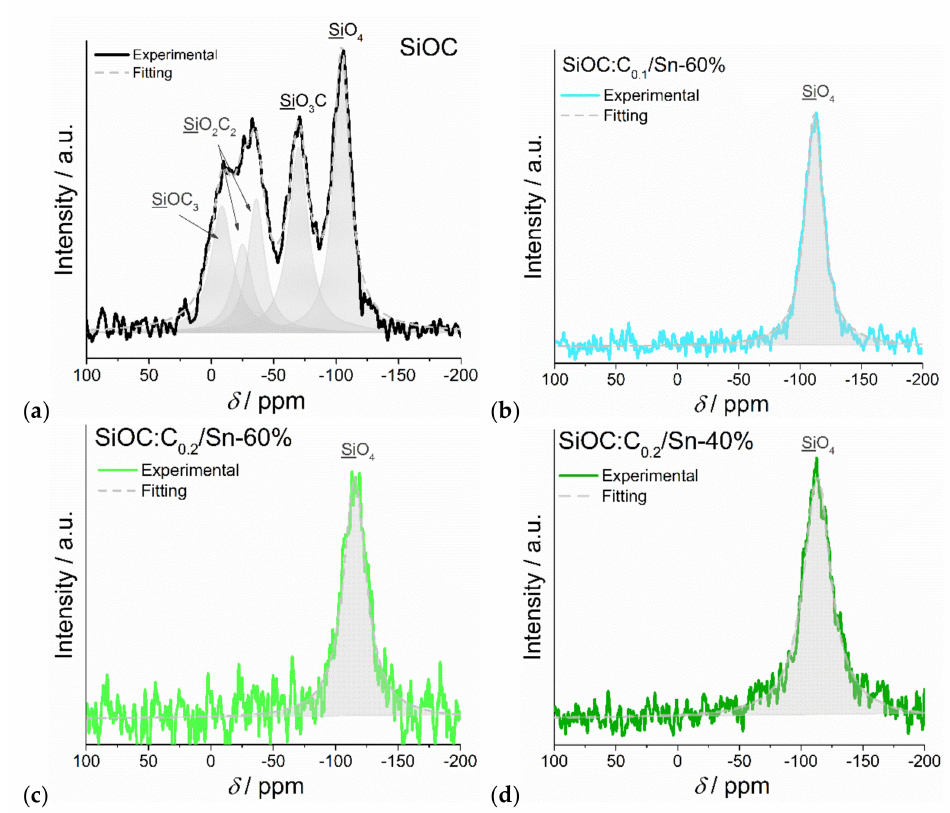
Figure 6. 29 Si NMR spectra for ( a ) SiOC ( b ) SiOC:C 0.1 /Sn-60%, ( c ) SiOC:C 0.2 /Sn-60% and ( d ) SiOC:C 0.2